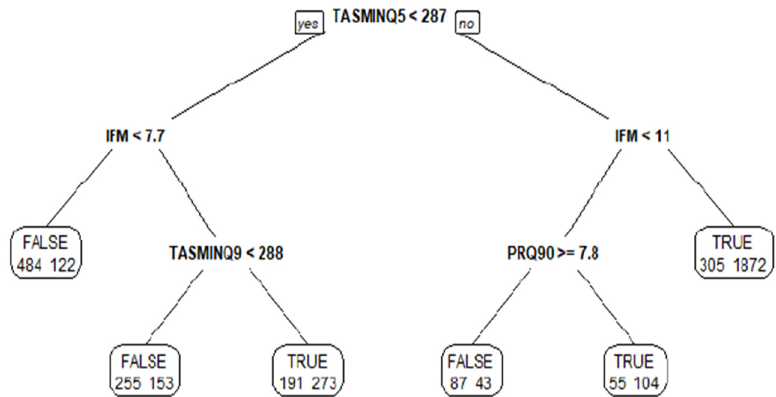
Figure 9. Extract of the decision tree developed for the study.